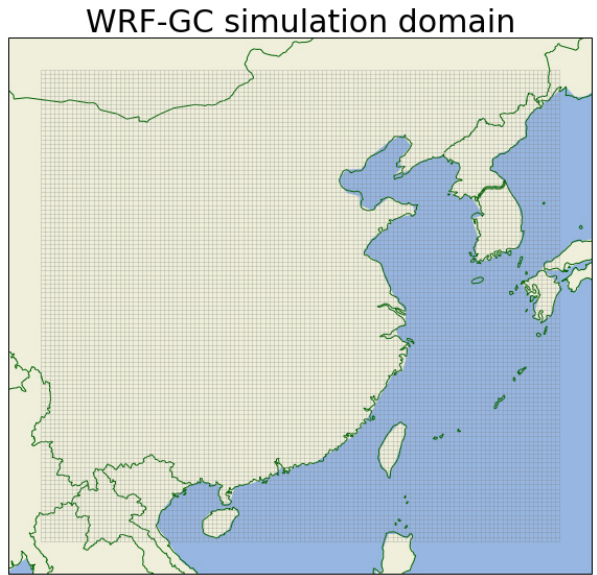
Figure A1. Domain setting of WRF-GC. Gray bordered grids represent the model grids of 27 × 27 km 2 resolution. Table A1. Averages of the bottom-up NOx emissions (MEIC, prepared for year 2017) during the three periods and relative changes between the three periods: P1 (January 1 to January 23), P2 (January 24 to February 9), and P3 (February 10 to March